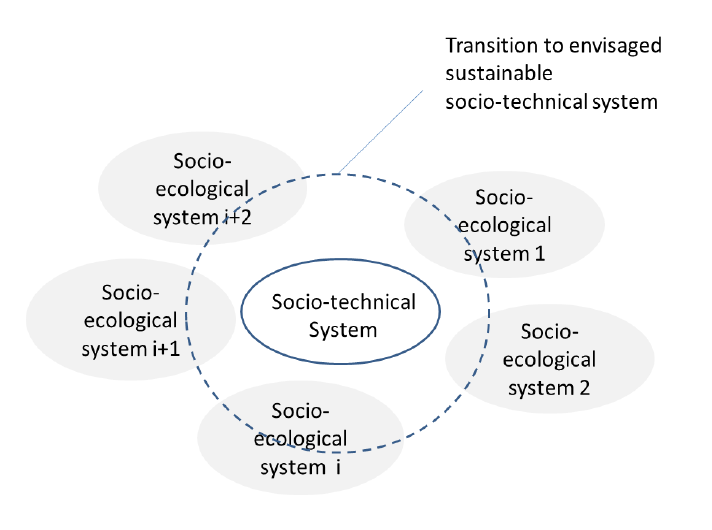
Figure 1 . Socio-technical systems in the context (according to